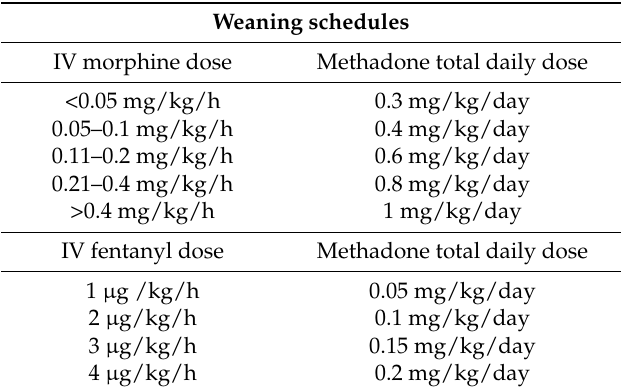
Table 2. Sample Opioid Weaning